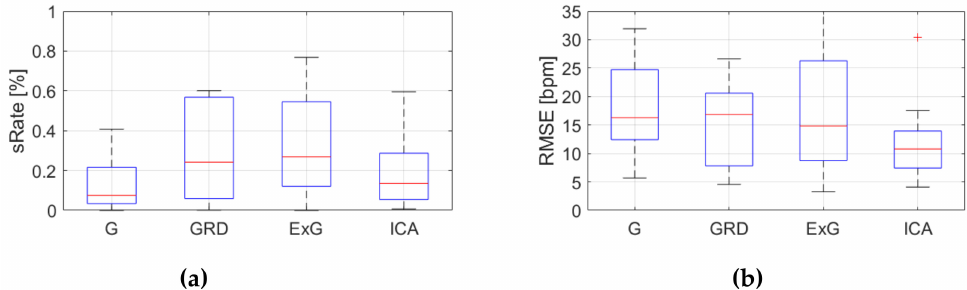
Figure 18. Comparison of signal extraction methods, algorithm No.3 (TIME), part 2: ( a ) box plots for sRate ; ( b ) box plots for RMSE . Blue lines—IQR range, red line—median value.